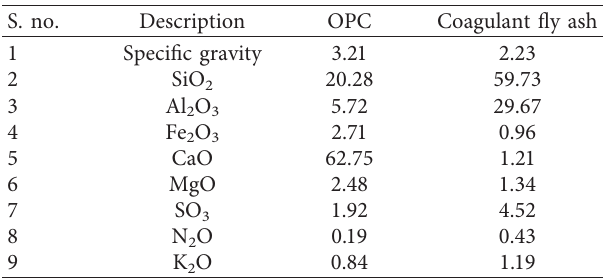
Table 1: Property of coagulant fly ash and ordinary Portland cement. S.